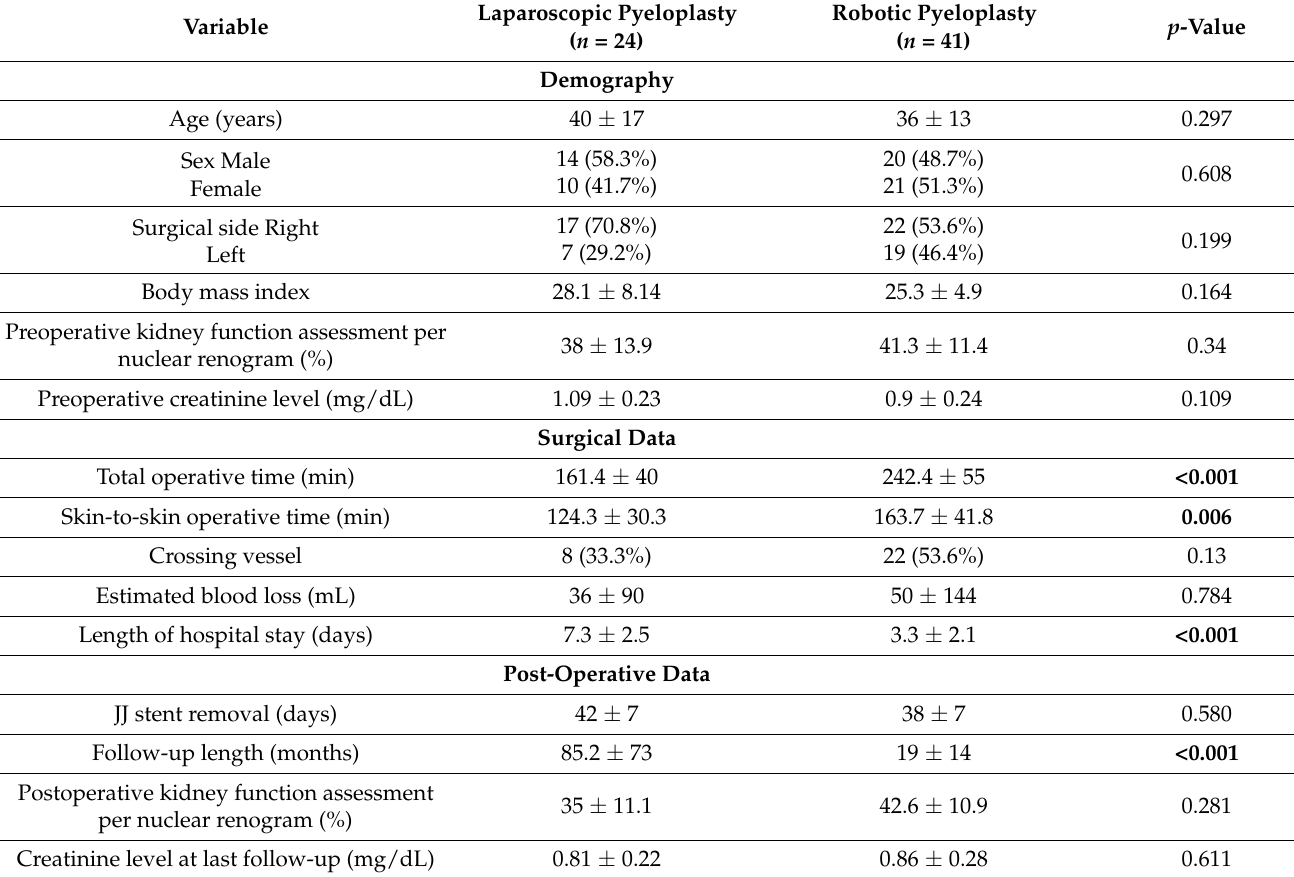
Table 1. Demographic, surgical, and postoperative data of the study participants according to surgical